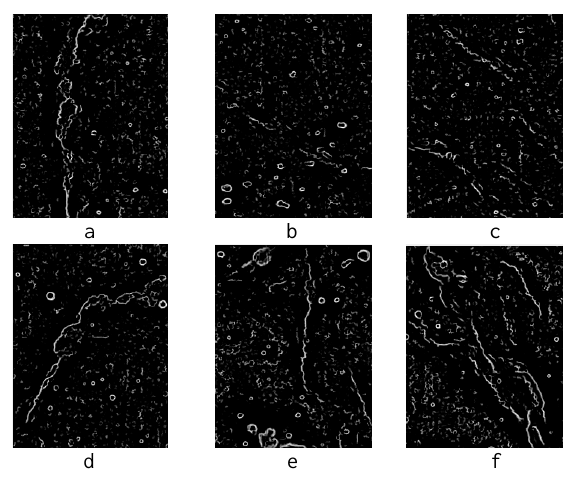
Figure 5. Results obtained from the phase symmetry measure.